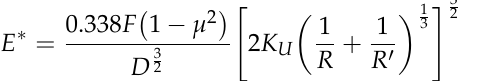
Figure 8. The curvature radius between the seed–upper contact surface and the seed–